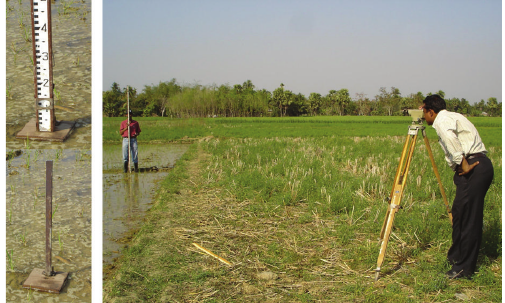
Figure 3: Theodolite used to measure